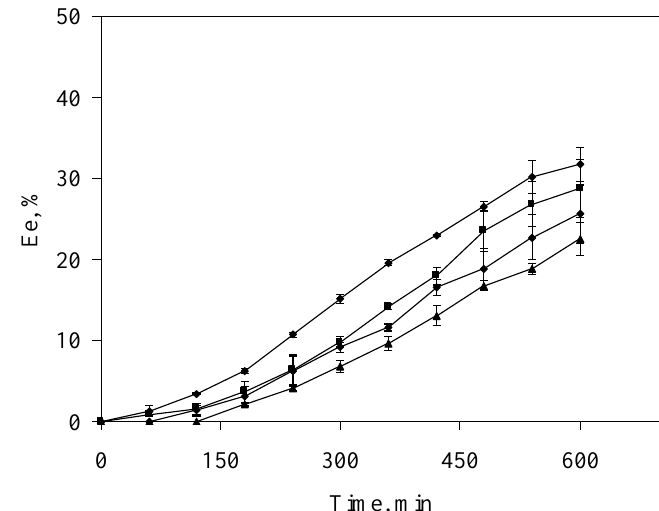
Figure 2. Extraction efficacy dependence on dissolved organic carbon (DOC) concentration. (●) 0 Table 2. Extraction efficacy and theoretical major species distribution depending on DOC concentration. DOC, mg · L −